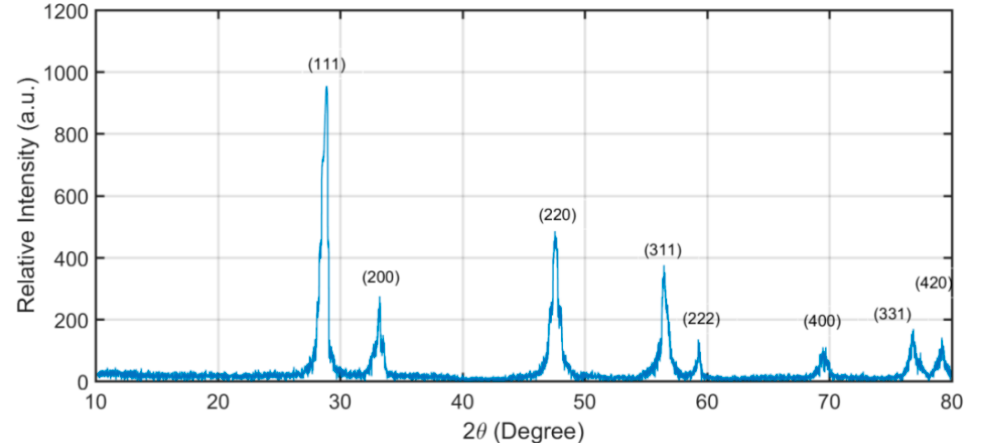
Figure 1. XRD intensity versus 2 θ indicating ceria